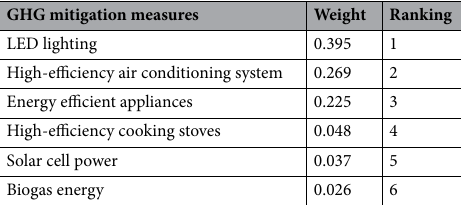
GHG mitigation measures Weight